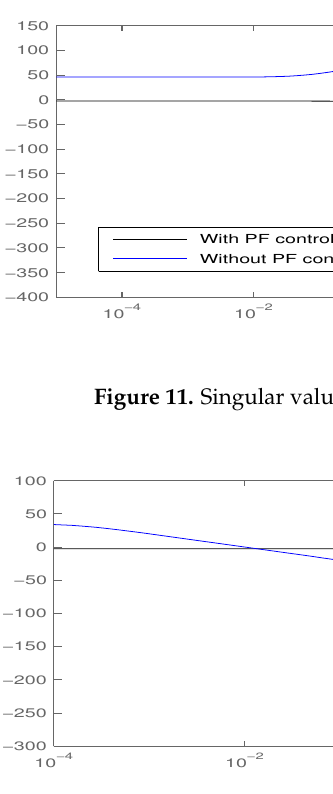
Figure 12. Singular values plot of supply error control loop ( ∆ P ∗ e → ∆ P e